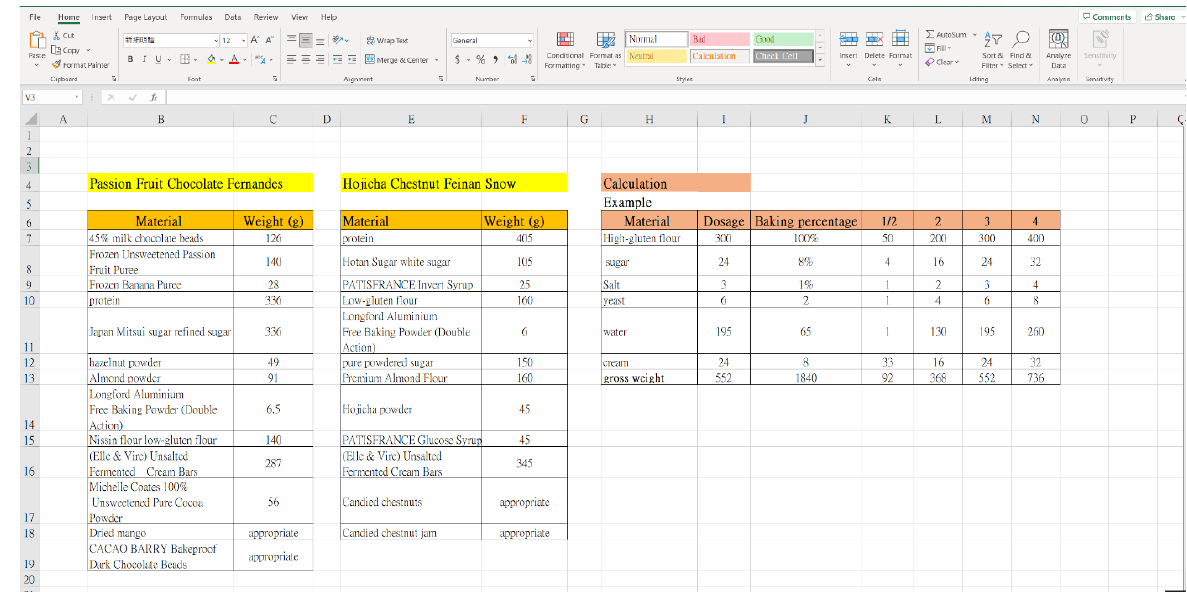
Figure 3. Dessert recipes and cost calculation in Microsoft Excel Computational System.